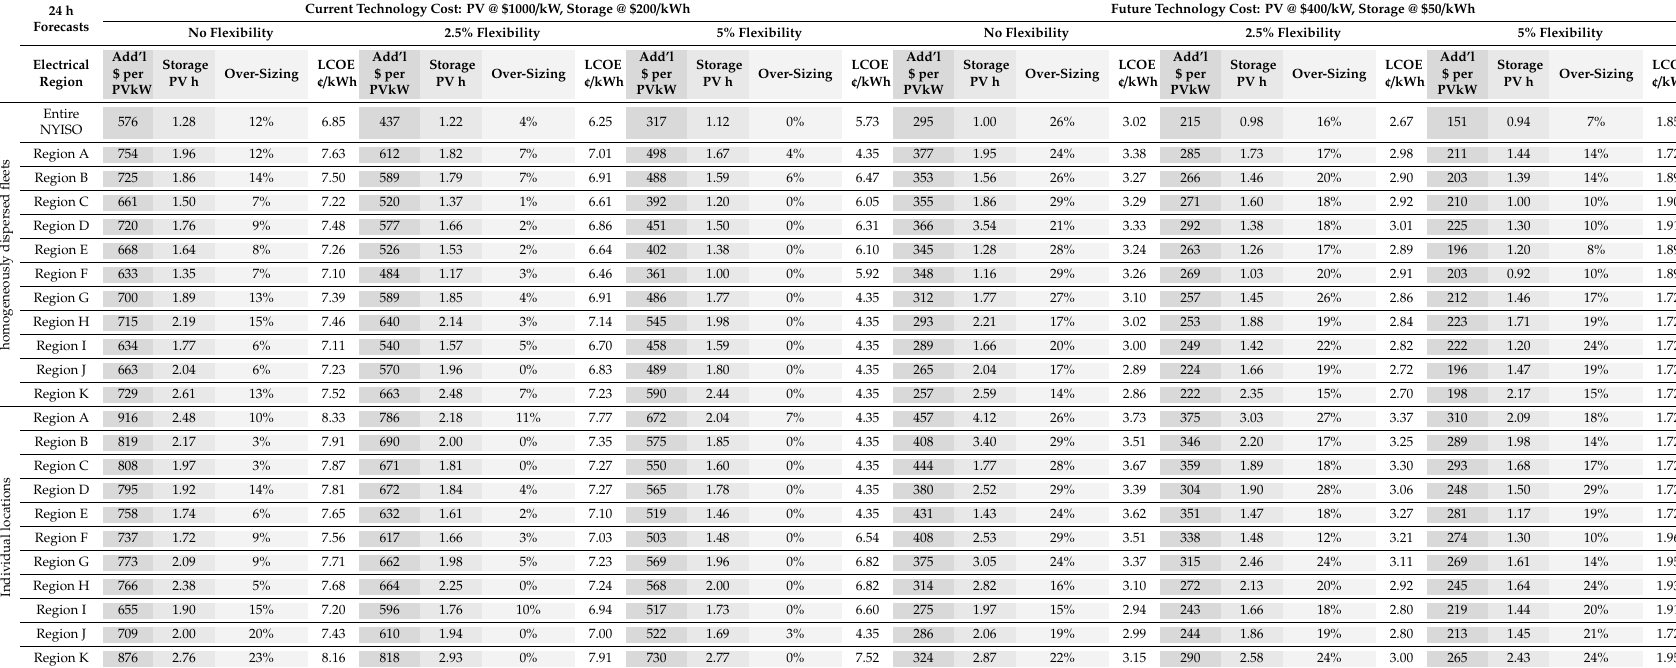
Table A9. Twenty-four-hours-ahead firm forecast results applying